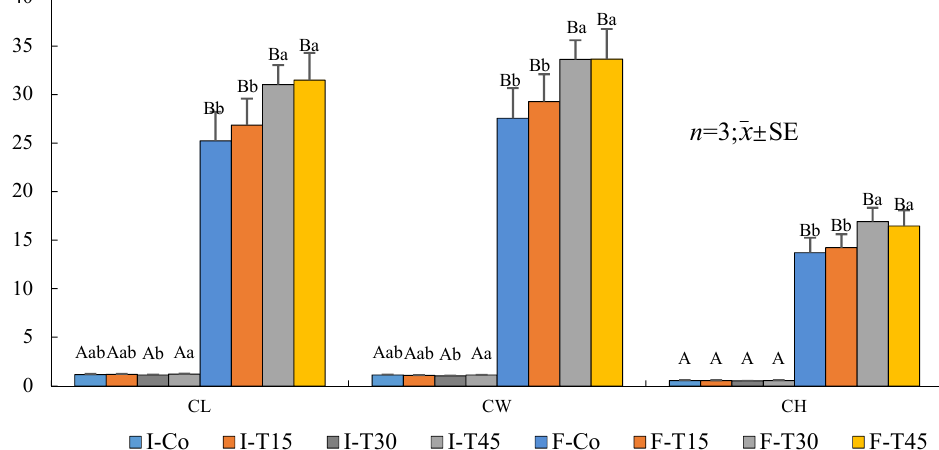
Figure 2. Comparison of morphological parameters of crabs among different protein-content groups. I, the initial size in the beginning of experiment; F, the final size at end of experiment; CL, carapace length; CW, carapace width; CH, carapace height. Different letters indicate the significant difference among treatment groups ( p < 0.05). Table 2. Effects of different dietary protein content levels on the growth performance and yield ( n = 3 ; x ± SD) of juvenile Chinese mitten crabs. Growth performance and yield